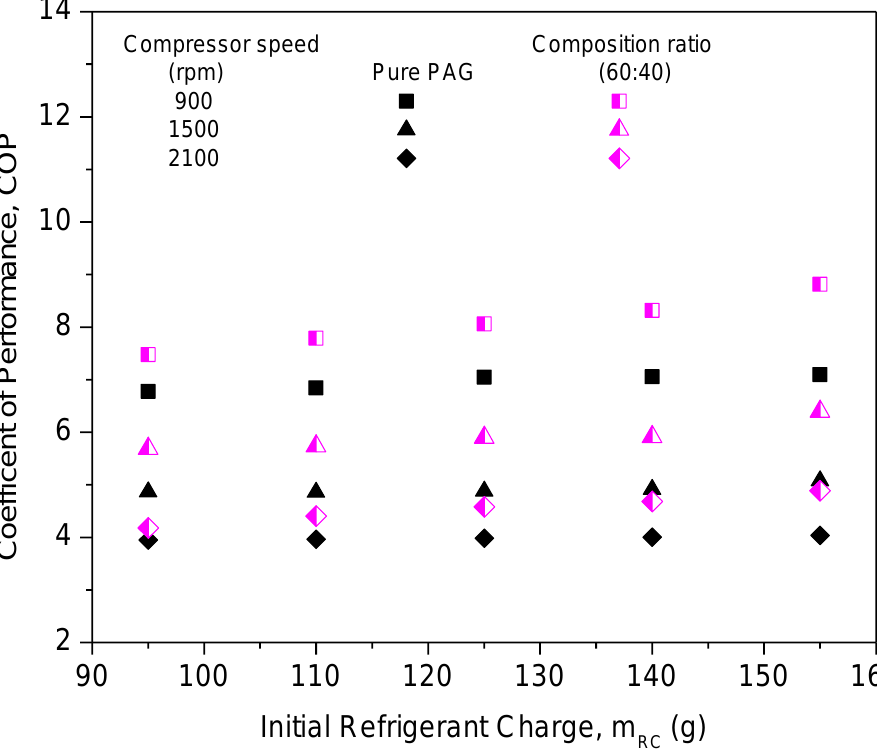
Figure 14. Coefficient of performance of the hybrid nanolubricants at the optimum 60:40 composition ratio.